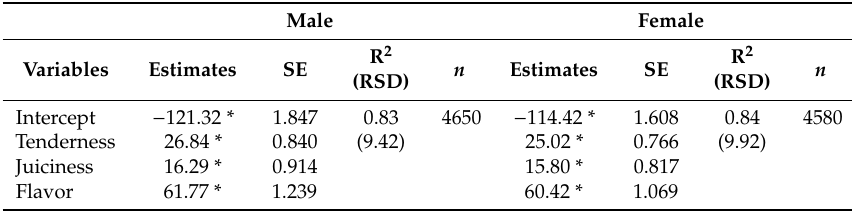
Table 7. Pairwise comparisons of gender on consumer satisfaction.